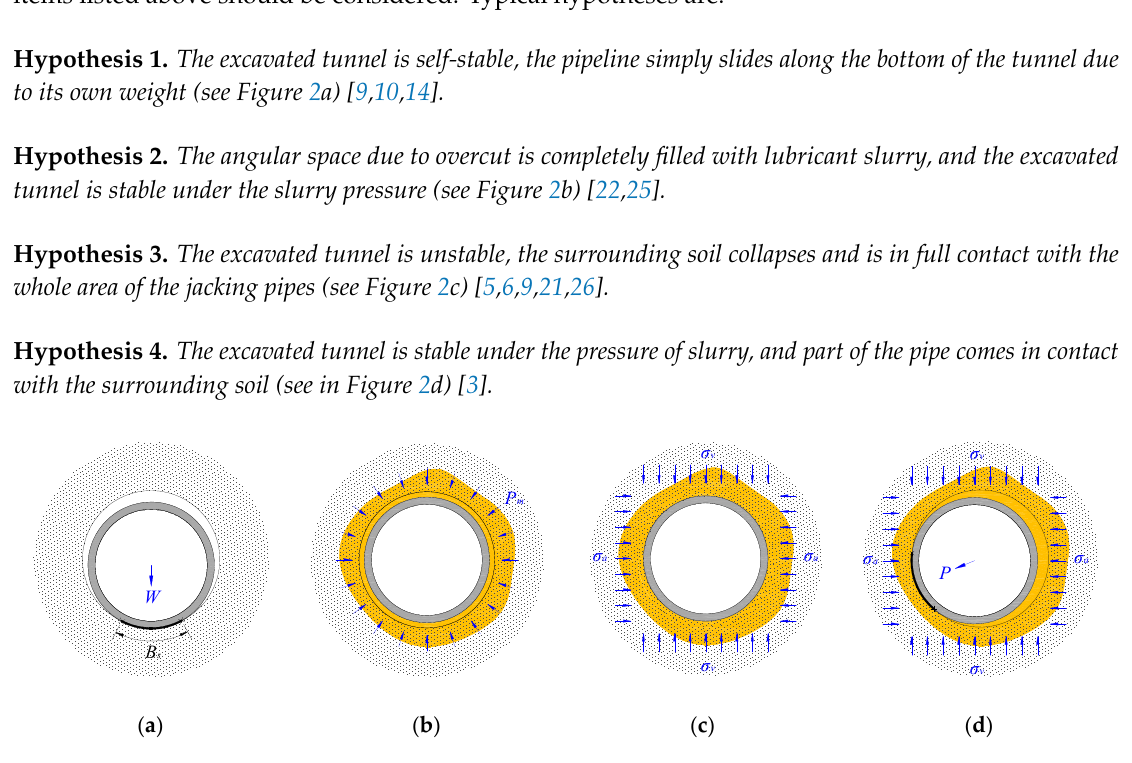
Figure 2. The models to calculate friction resistance according to different hypotheses: ( a ) Hypothesis 1; ( b ) Hypothesis 2; ( c ) Hypothesis 3; ( d ) Hypothesis 4.